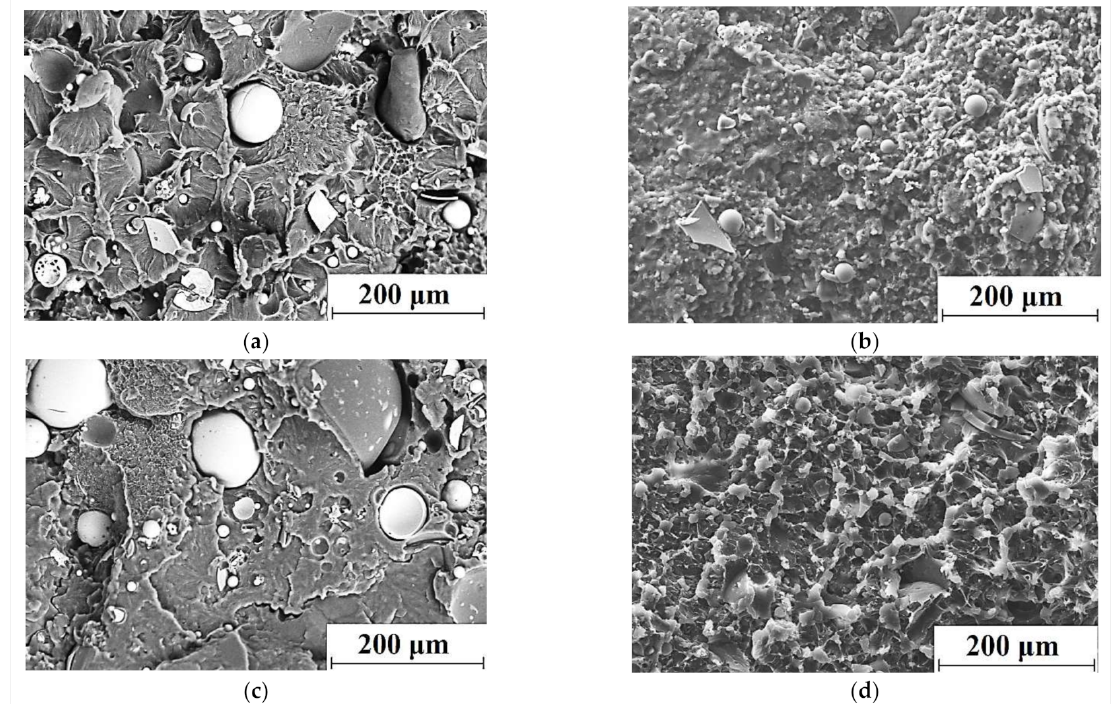
Figure 2. The scanning electron microscopy (SEM) micrographs of the supermolecular structure of the ‘UHMWPE +17%HDPE-g-VTMS+12%PP+5%HGS’ ( a , b ) and ‘UHMWPE+17%HDPE-g-VTMS+12%PP+10%HGS’ ( c , d ); HC-PM ( a , c ), hot compression by the Twin-Screw Extruder (HC-TSE) ( b , d ).